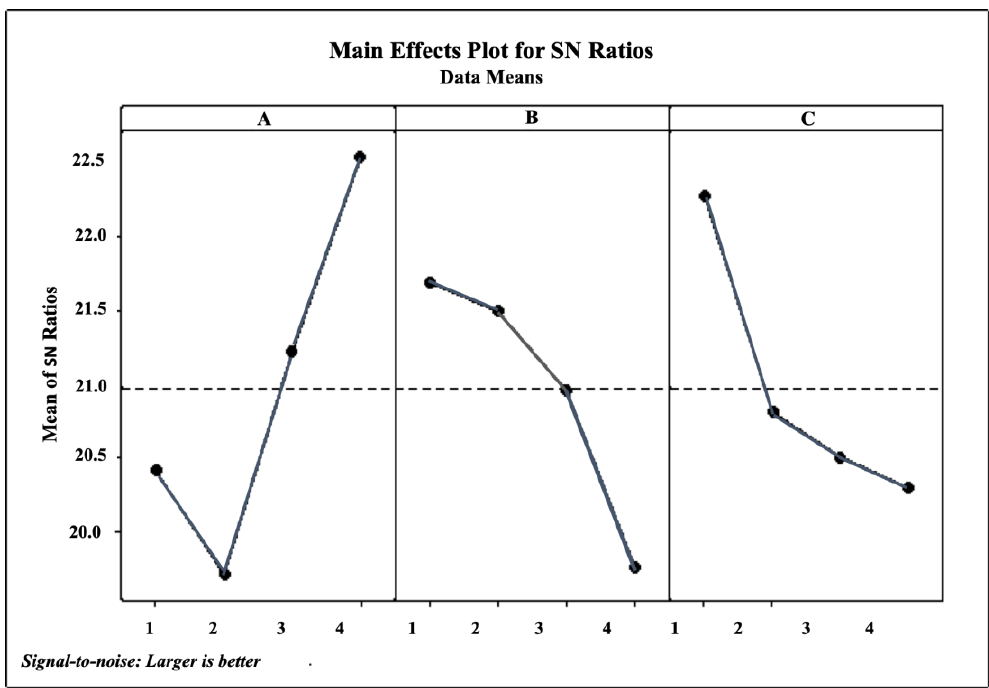
Figure 2. Main effects plot for SN ratio of AA. ( A ) Solvent concentration (50, 60, 70 and 80%), ( B ) extraction time (50, 60, 70 and 80 min), and ( C ) solid-to-liquid ratio (0.02, 0.04, 0.06 and 0.08 g/mL).